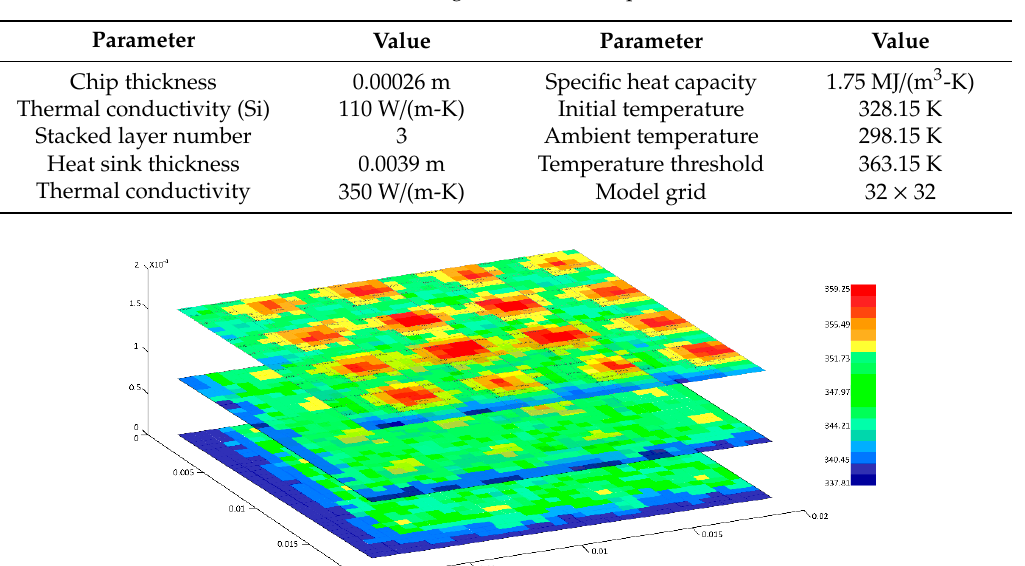
Table A1. Parameter configurations in HotSpot thermal model.